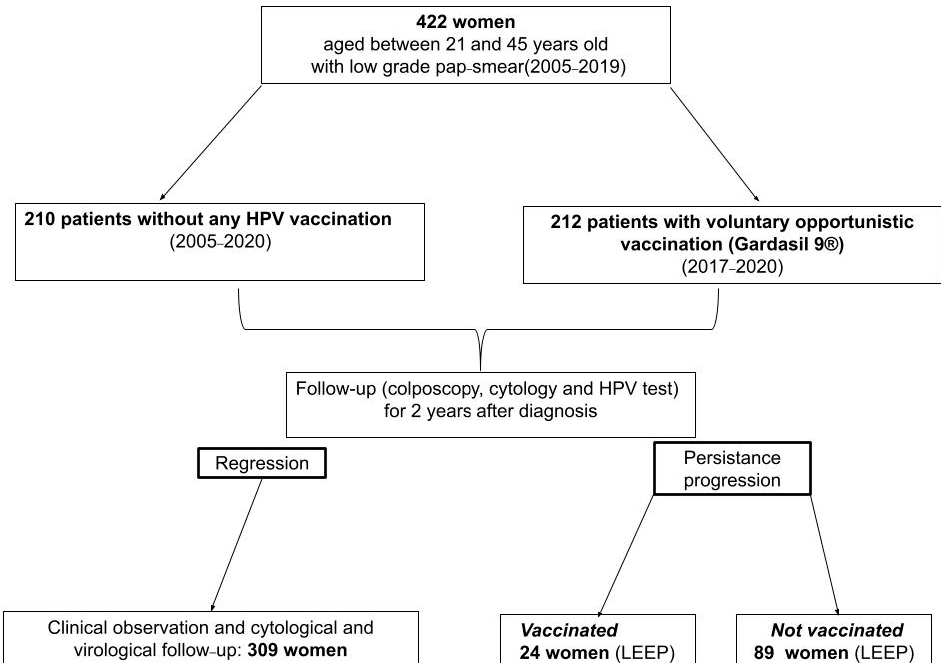
Figure 1. Flow chart of patients enrolled in the study.